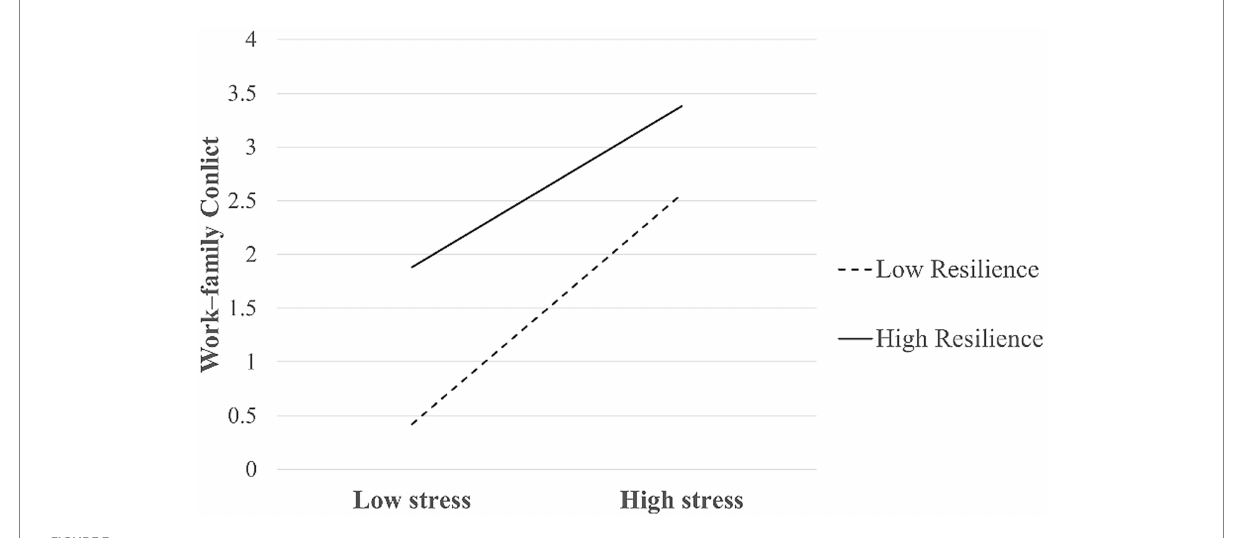
FIGURE 3 Resilience as a mediator between job stress and work–family